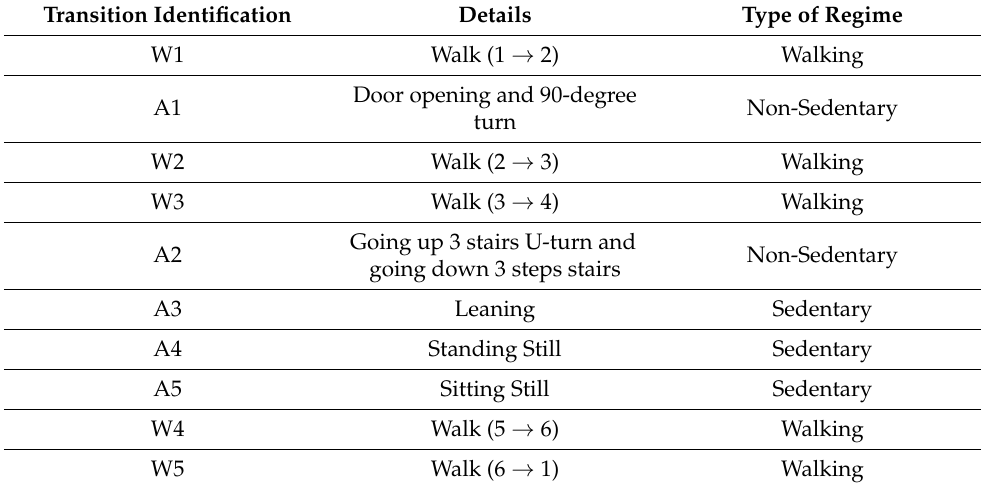
Table 1. Details of annotated